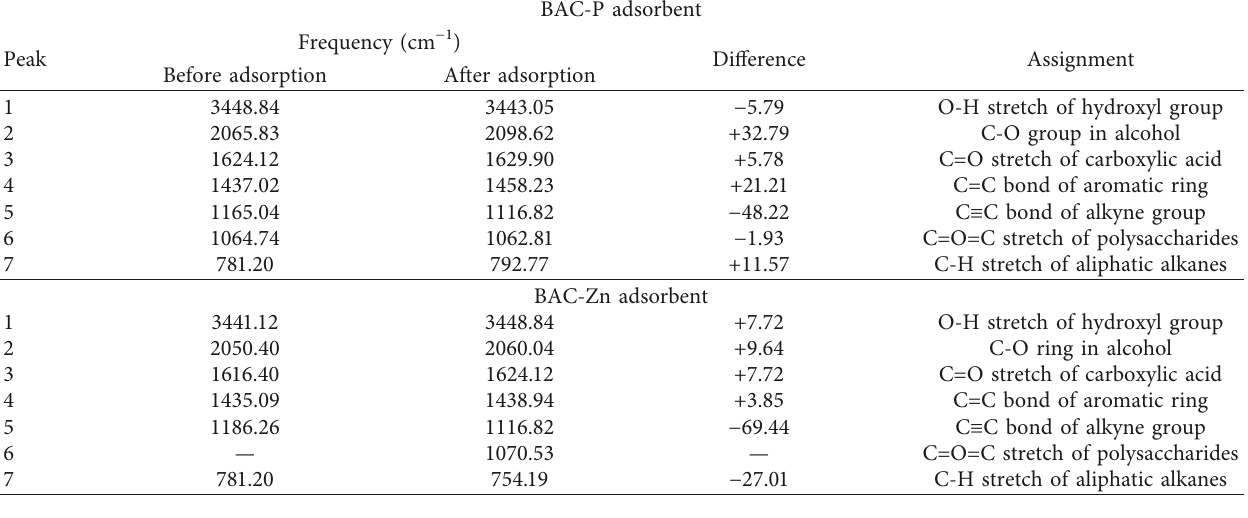
Table 4: FTIR spectral analysis of BAC-P and BAC-Zn adsorbents.